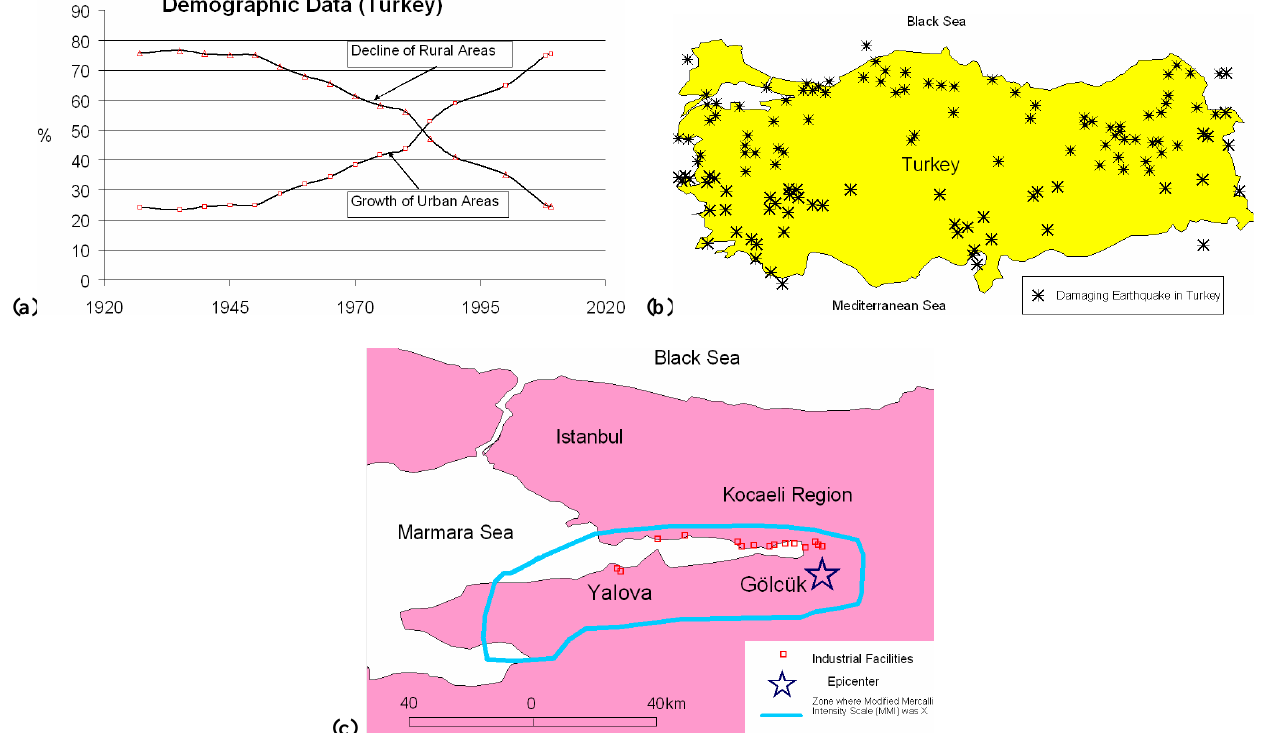
Fig. 2. (a) Population Distrubution in Turkey. (b) Epicentral location for damaging earthquakes occurring from 1900–2003 obtained from Figure 2c. Map showing the epicentre of the Kocaeli earthquake of August 17, 1999 Figure 2b. Epicentral location for damaging earthquakes occurred during 1900 – 2003 “General Management of Disaster Affairs of Turkey” (redrawn from ¨Ozmen, 2003). (c) Map showing the epicentre of the Kocaeli earthquake and the location of industrial facilities (redrawn from Cruz [39]) obtained “General Management of Disaster Affairs of Turkey” (redrawn from Özmen of 17 August 1999 and the location of industrial facilities (redrawn from Cruz, [37])